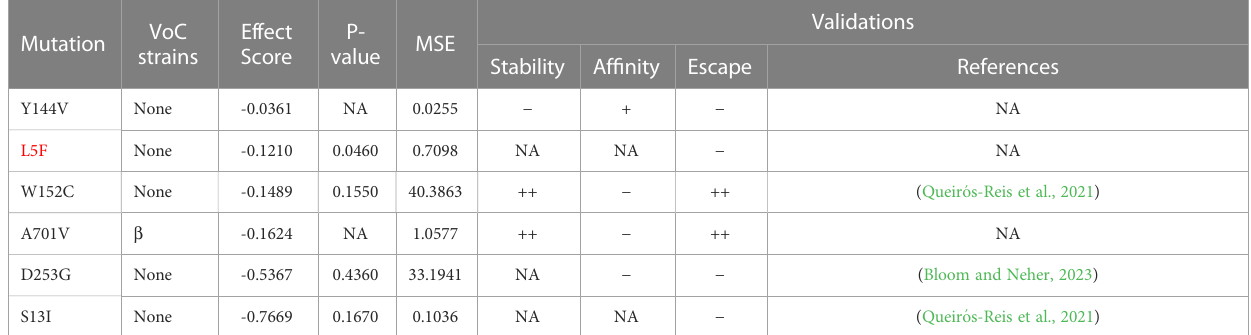
TheeffectscorerepresentsthestatisticalcontributionofSpikemutationstotheviral fi tness.MSErepresentstheMeanSquareErrorofthecorrespondingmodel.Themutationaleffectisvalidated in the Spike protein stability, ACE2 binding af fi nity, the potential for immune escape, and supporting references, abbreviated as Stability, Af fi nity, Escape, and References, respectively. Symbol representations:++,highlypositiveeffect;+,potentialpositiveeffect; − ,nosigni fi cantpositiveeffect;NA,notapplicable.VoCstrainsrelatedtoeachmutationarerepresentedinGreekletters.The mutation with no validated positive effect is in Table 1, except P26- mutation, possess one or more validated